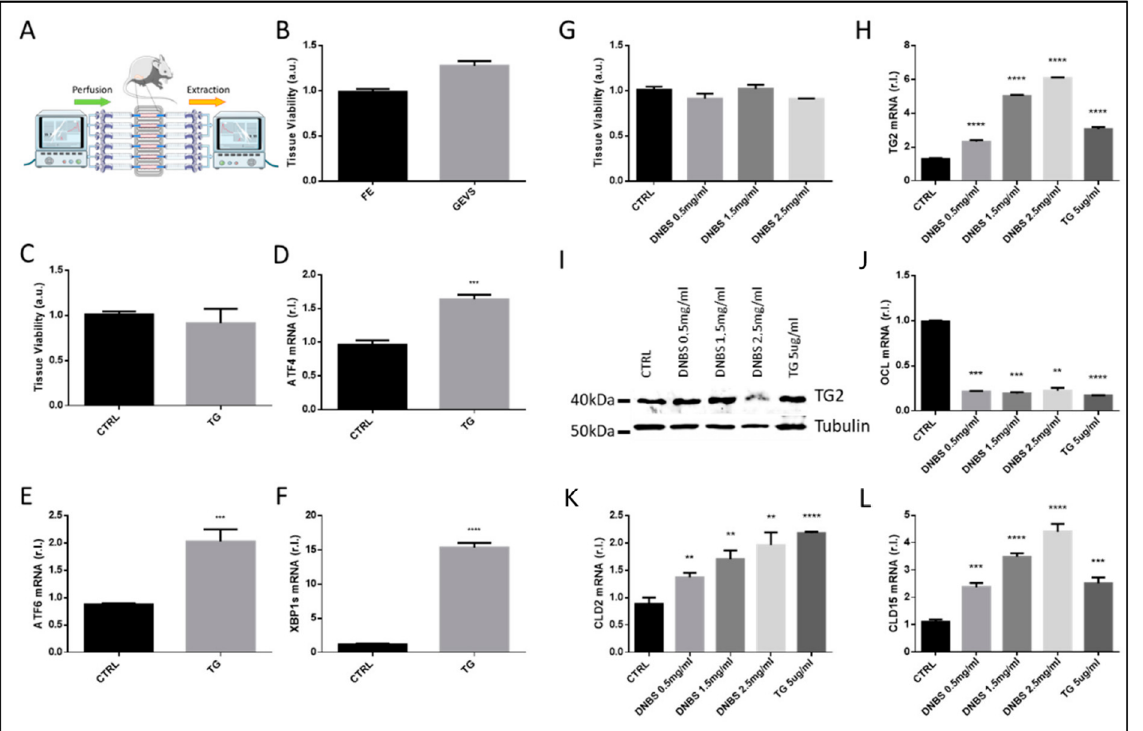
Figure 1. GEVS configuration and DNBS-stimulated tissue stress and altered permeability. ( A ) GEVS schematic representation in which the configuration of chambers is highlighted. ( B ) Tissue viability of colon cultivated 5 h in the gut-ex-vivo system (GEVS) or freshly explanted ( E , F ). The colon was cultivated 5 h in the GEVS and untreated (CTRL) or treated with Thapsigargin (TG), and tissue viability was evaluated by MTT Assay ( C ), or total RNA was isolated and ATF4 ( D ), ATF6 ( E ) or spliced XBP1 (XBP1s, ( F )) expression levels were evaluated by qPCR. Colon was cultivated 5 h in a GEVS and untreated (CTRL) or treated with the indicated concentrations of DNBS, or Thapsigargin (TG), tissue viability was evaluated by MTT assay ( G ) and cellular stress was evaluated by measuring the expression of TG2, by qPCR ( H ) and western blotting analysis ( I ). Tissue permeability was evaluated by measuring the mRNA levels of Tight Junction (TJ) components Occludin (OCL, ( J )), Claudin-2 (CLD2, ( K )), or Claudin-15 (CLD15, ( L )), by qPCR. Each panel is representative of experiments performed in triplicate. Histograms represent mean ± SD of triplicate sample; **** p < 0.0001; *** p < 0.001; ** p < 0.01.